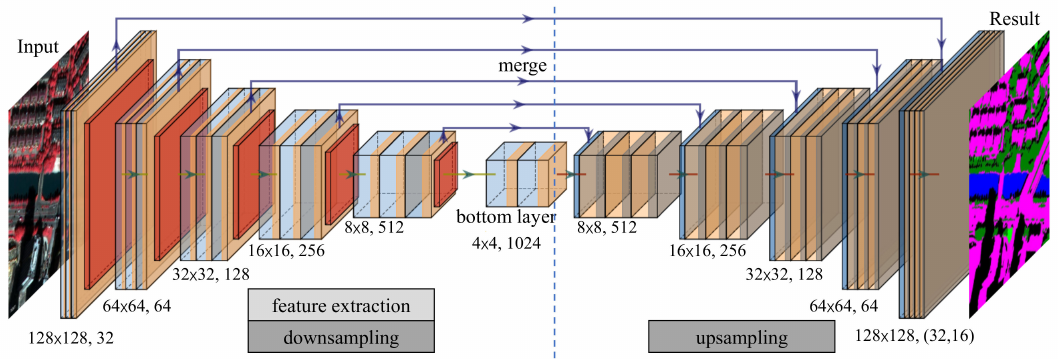
Figure 5. The improved U-net structure is composed of eleven convolution